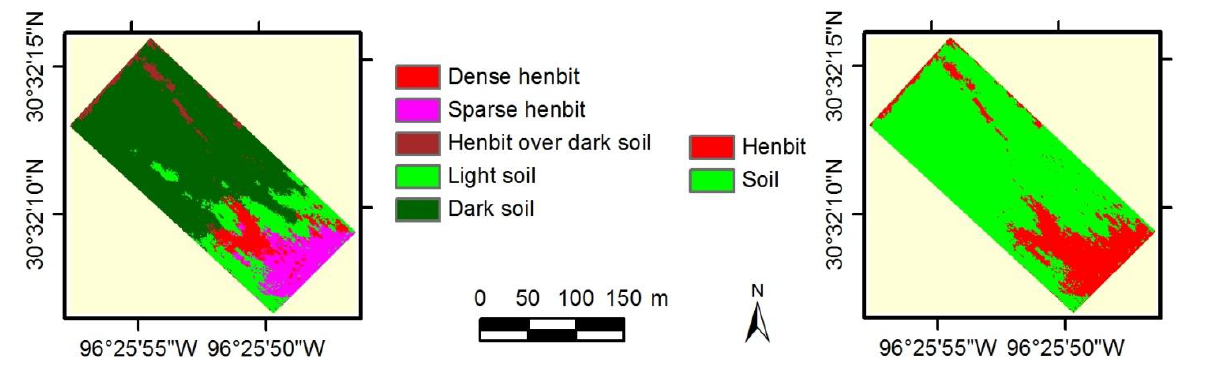
Figure 10. Five-zone classification map and merged two-zone prescription map derived from the images shown in Figure 9 based on maximum likelihood